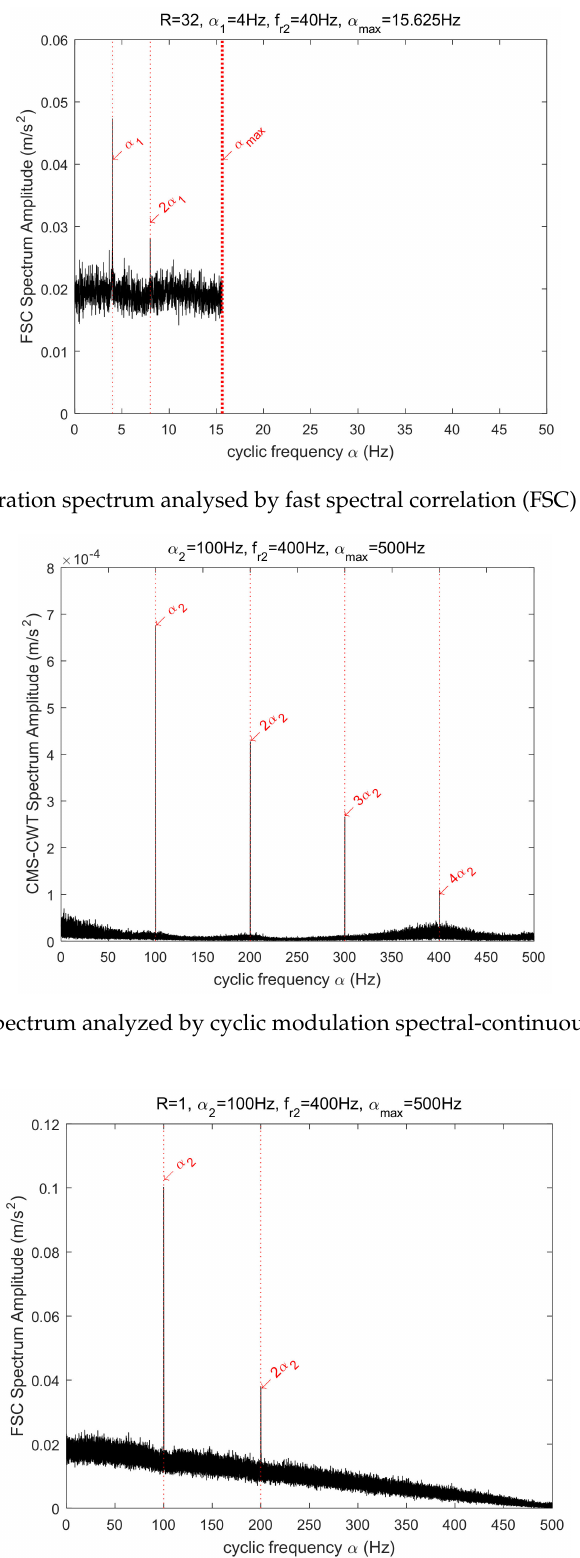
Figure 5. Vibration spectrum analysed by FSC with R =